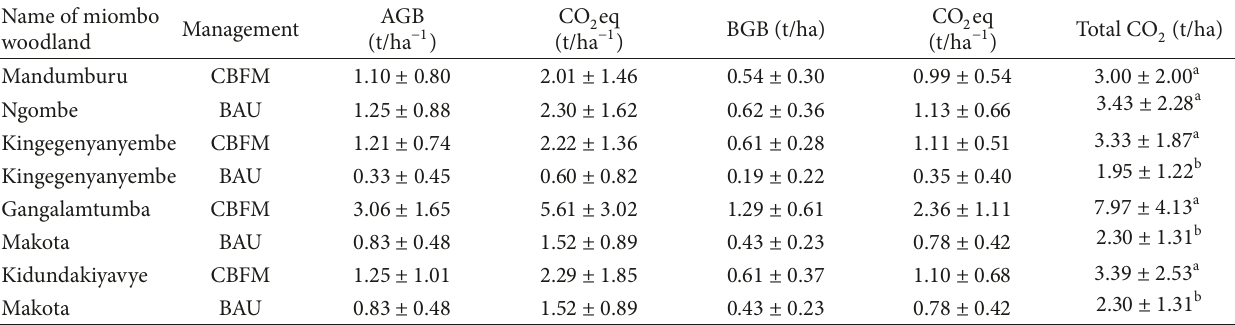
Table 4: Effects of woodland management on biomass and carbon stock in studied